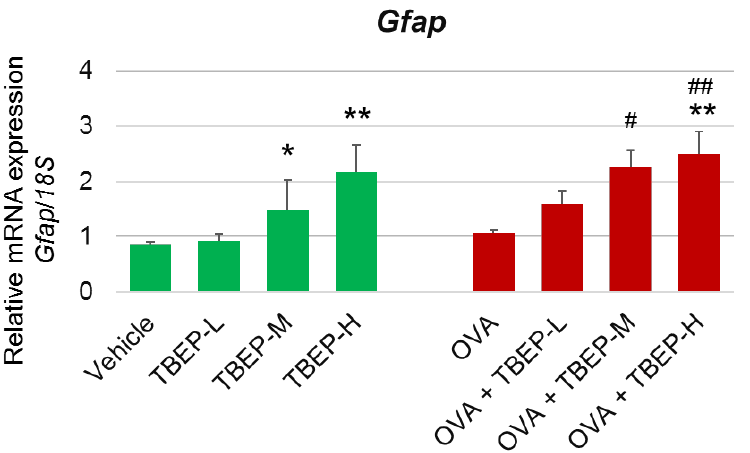
Figure 5. Messenger RNA expression levels of astrocyte marker in the hippocampus. Gfap mRNA in the hippocampus of TBEP-exposed male mice with or without OVA immunization. (n = 6, * p < 0.05, ** p <0.01 vs. vehicle alone; # p < 0.05, ## p < 0.01 vs. OVA alone).